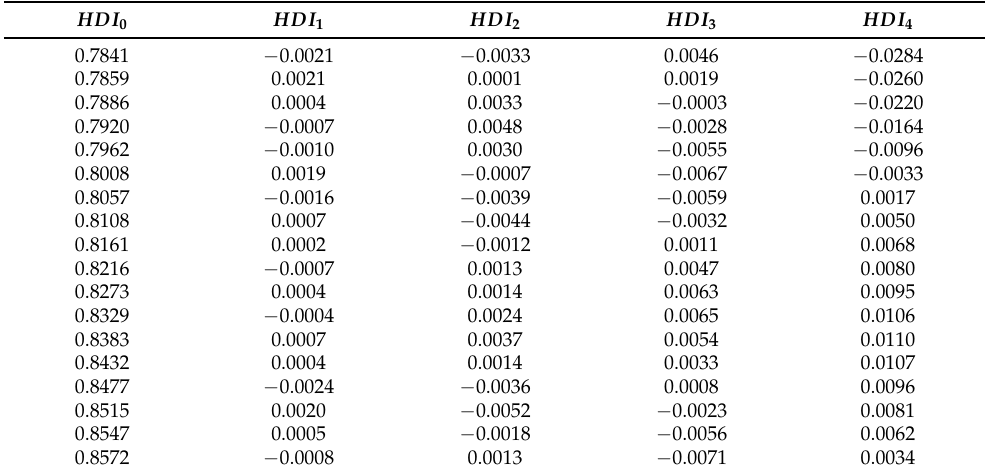
Figure 8. The wavelet decomposition of the variable V 8 at the level 4. Next, as the components of our sample are completed and the sample has now no missing values, we provide the resulting quality of life index HDI issued from the model (5). The values are provided in Table 10 below. Table 10. The HDI index, real and time-scale model